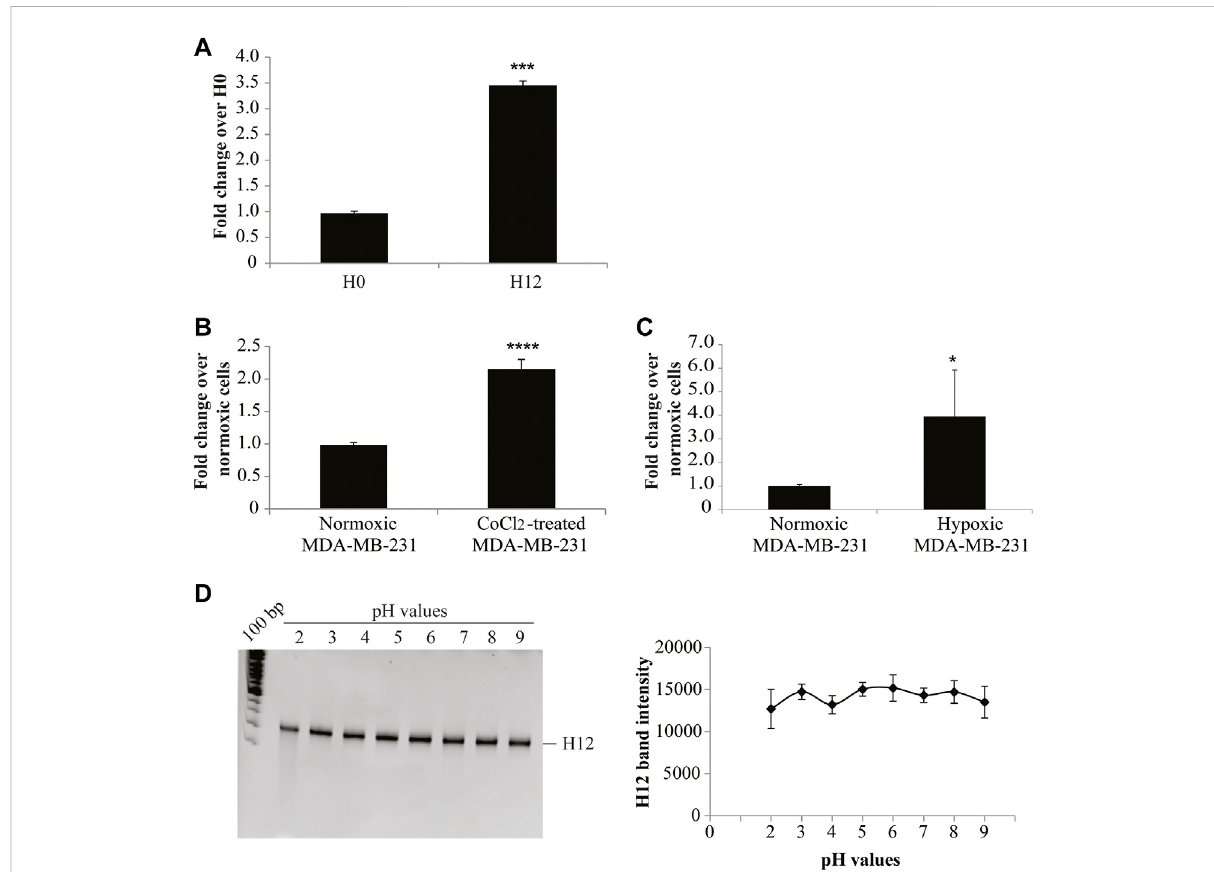
H12 characterization. (A) The binding capability of the starting and the fi nal aptamer pool (indicated as H0 and H12, respectively) on CoCl 2 - inducedMDA-MB-231cellswasanalysedbyanRT-qPCRassay.InthegraphareindicatedthefoldchangesoverH0.Theerrorbarsshowthemean± standarddeviationvaluesonduplicates( n =2)andstatisticswerecalculatedusingStudent ’ st-test,*** p < 0.001; (B) BindingassayofH12byRT-qPCR performed on CoCl 2 -induced and normoxic MDA-MB-231 cells, used as a negative control. In the graph we indicate the fold changes calculated over normoxic MDA-MB-231 cells. Error bars show the mean ± standard deviation values on replicates ( n = 4) and statistics were calculated using Student ’ s t-test, **** p < 0.0001. (C) Binding assay of H12 by RT-qPCR performed on hypoxic chamber-mediate MDA-MB-231 and normoxic MDA-MB-231 cells, used as a negative control. In the graph we indicated the fold changes calculated over normoxic MDA-MB-231 cells. The error bars show the mean ± standard deviation values on replicates ( n = 4), and statistics were calculated using Student ’ s t-test, * p < 0.05. (D)